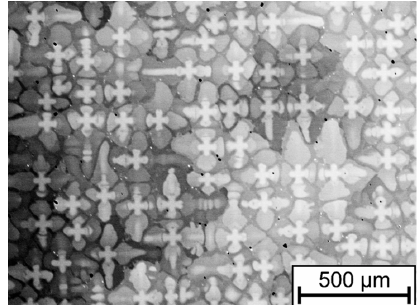
Figure 1. Crystal mosaicity in a Ni-based superalloy which was prepared by seeded Bridgman processing in the present study. The varying contrasts of dendrites are related to small misorientations (scanning electron microscopy image, back scatter contrast).